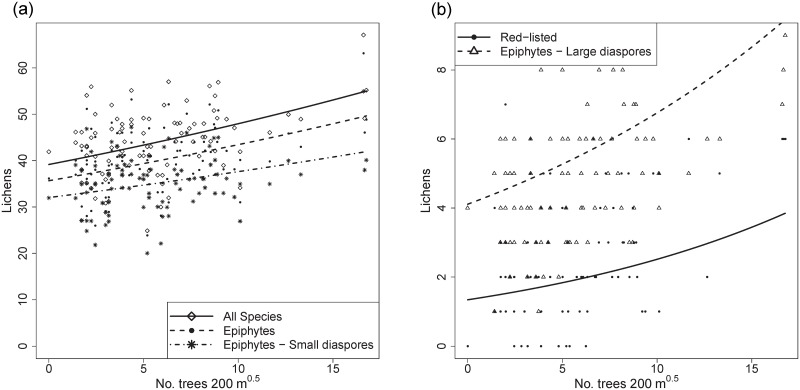
Effects of isolation on epiphyte richness.Effect plots for significant (p < 0.05, significance levels according to GLMM analyses; see Table 4) relationships between (a-b) the number of trees within a radius of 200 m (No. Trees 200 m) and the per tree richness of lichens. Regression lines represent the estimated values for the population mean, symbols represent the observations, i.e., the richness on each sampled tree.